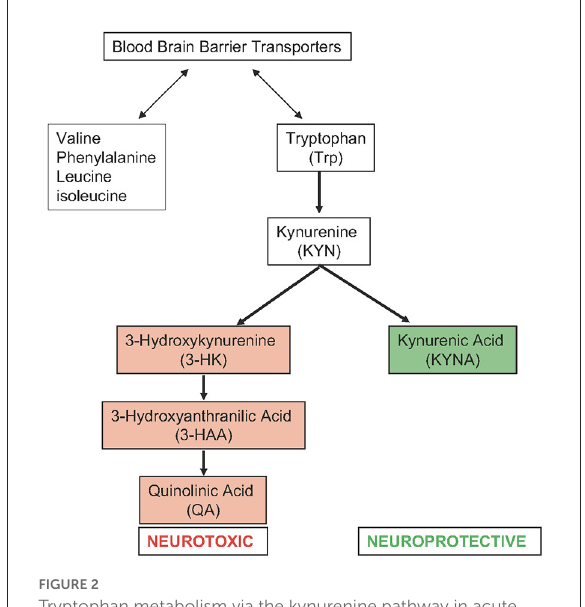
FIGURE2 Tryptophan metabolism via the kynurenine pathway in acute ischemic stroke (right) and amino acids that compete with tryptophan for transport across the blood brain barrier (left)